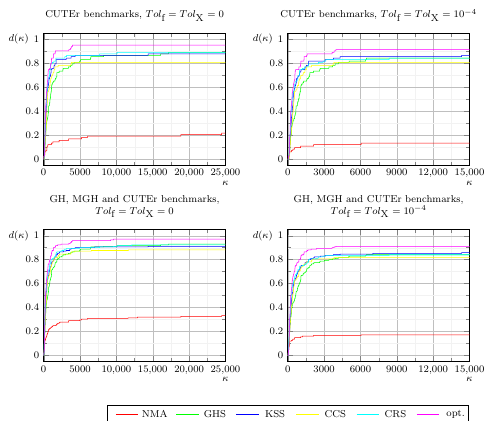
Figure 5. Data profiles for Constrained and Unconstrained Testing Environment, revisited (CUTEr) benchmark set and GH, MGH, and CUTEr benchmark sets combined, without ( Tol f = Tol X = 0) and with tolerance-based algorithm termination applied ( Tol f = Tol X = 10 − 4